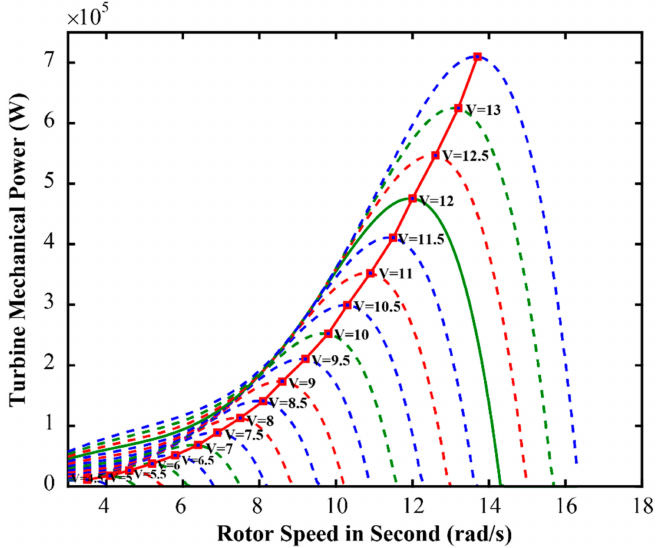
Figure 3. Turbine mechanical power curve vs. rotor speed under variable wind speeds.